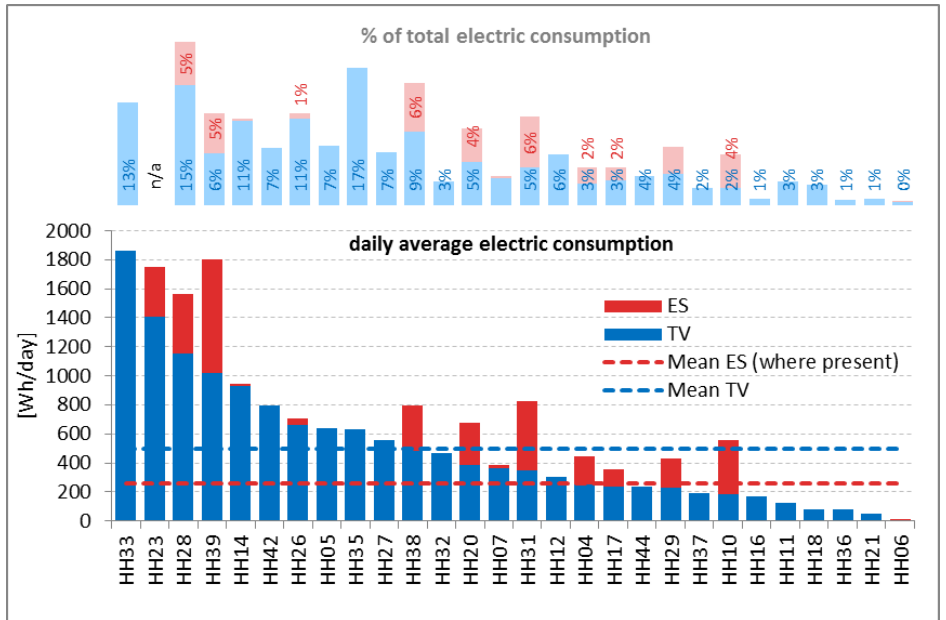
Figure 1. Energy consumption of televisions and entertainment systems in the different households (in Wh/day and as a percentage of the total electricity consumption).